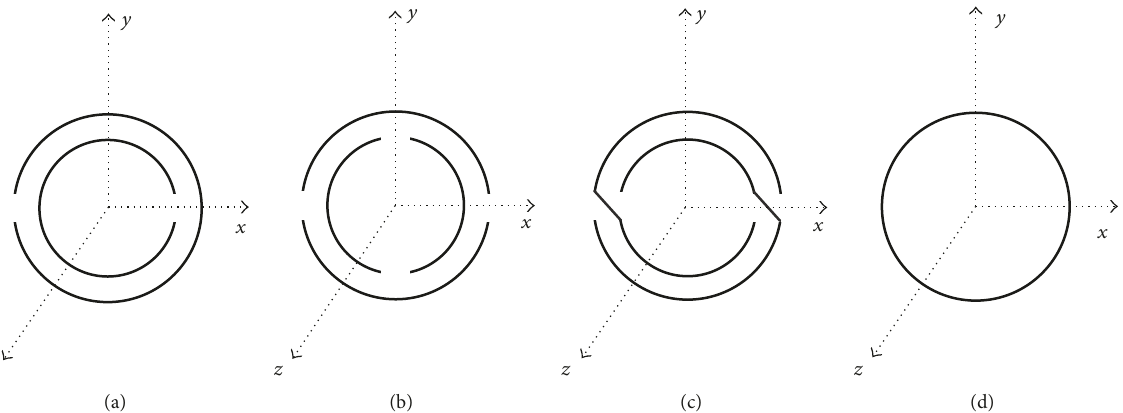
Figure 4: Examples of resonators used in the design of metamaterials: (a) conventional SRR; (b) double slit split-ring resonator (DS-SRR);